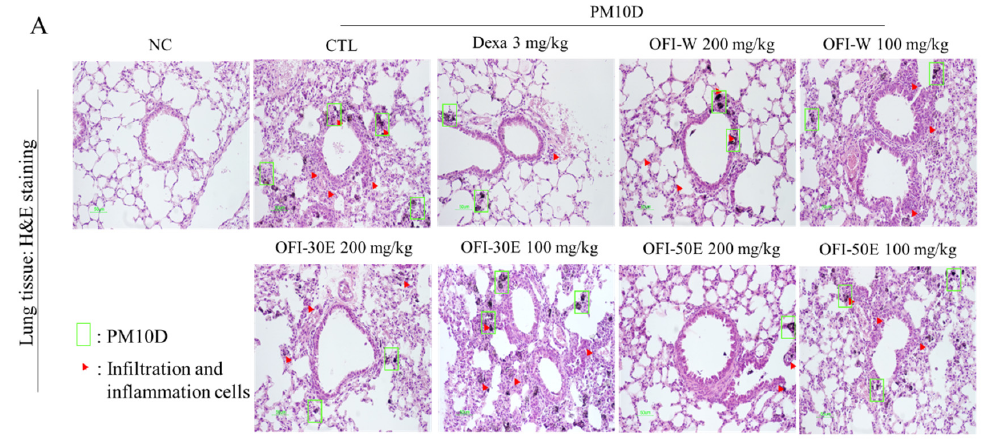
p < 0.005 vs. NC; *** p < 0.005 vs. CTL. ### p < 0.005 vs. NC; * p < 0.05, *** p < 0.005 vs. CTL.